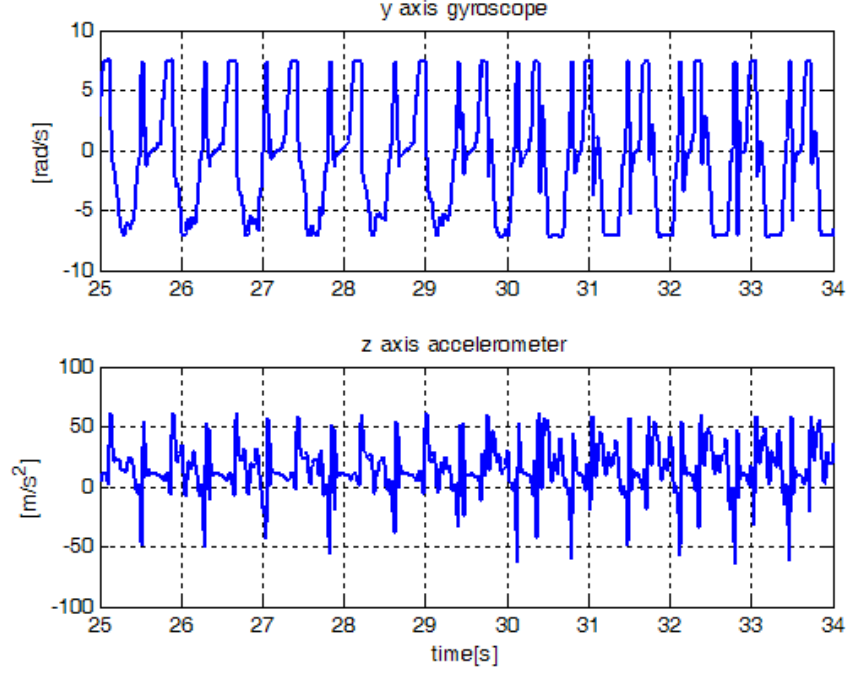
Figure 15. Zero velocity detection comparison when a person is running slowly and running fast(Z. V. I. means zero velocity